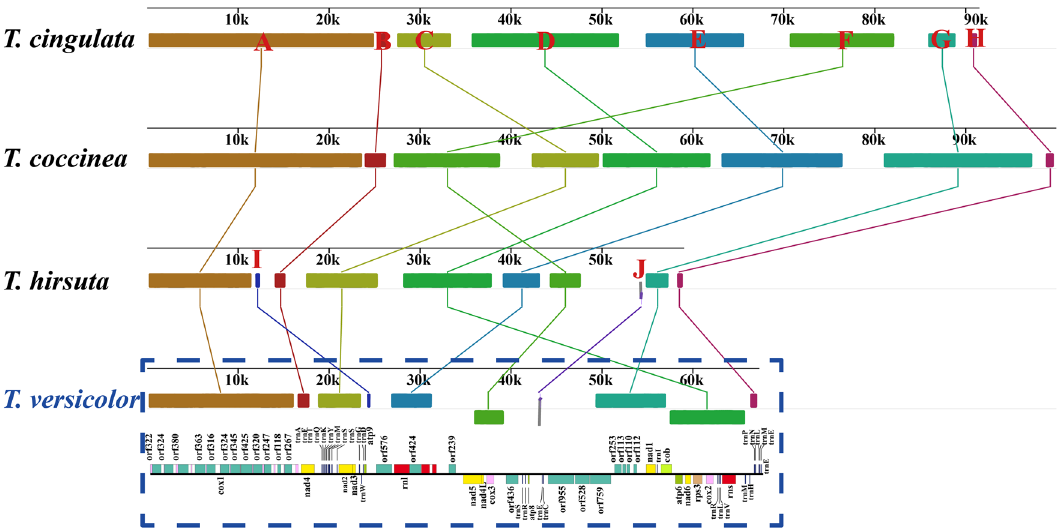
Figure 3. Mitochondrial gene collinearity analysis of 4 Trametes species using Mauve v2.4.0. Color blocks of the same color represent homologous regions between different mitogenomes. The schematic diagram of the mitogenome of Trametes versicolor is shown at the bottom of the